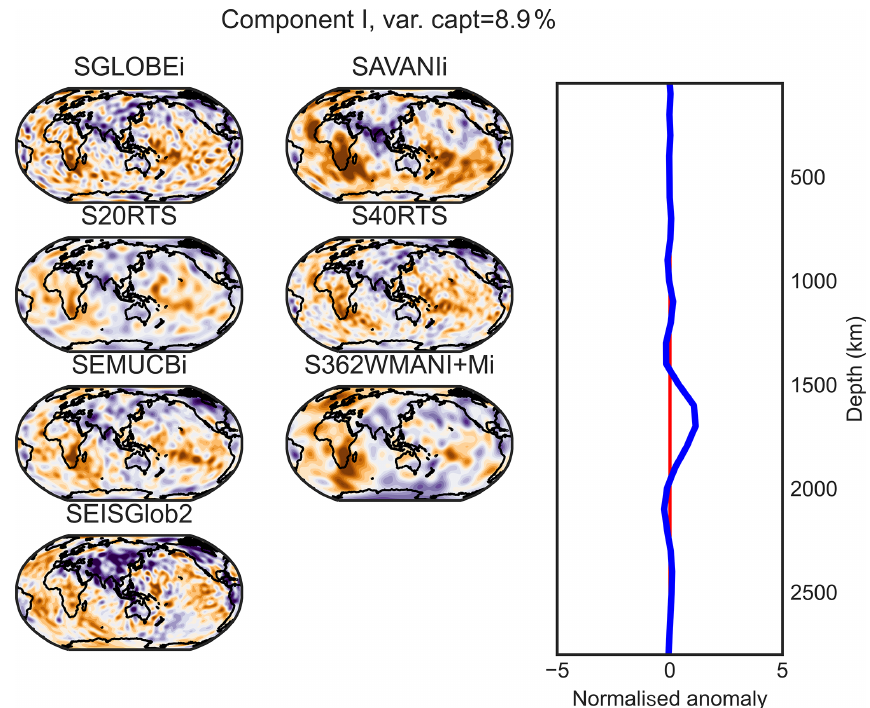
Figure D8. PC I (maximum at 1700km of depth) of the combined analysis of the isotropic parts of the models.